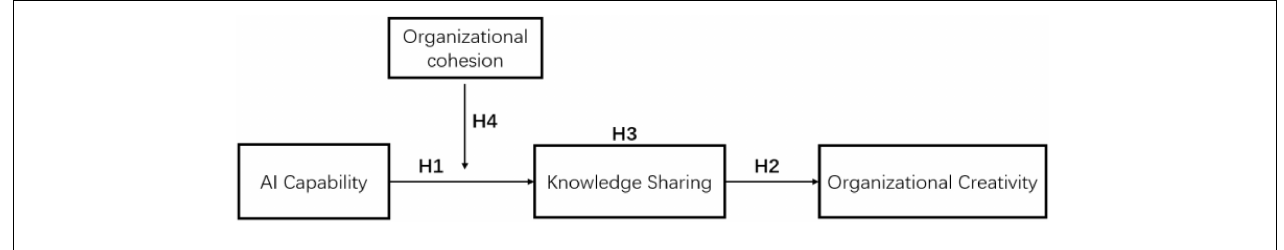
FIGURE 1 | Artificial intelligence capability